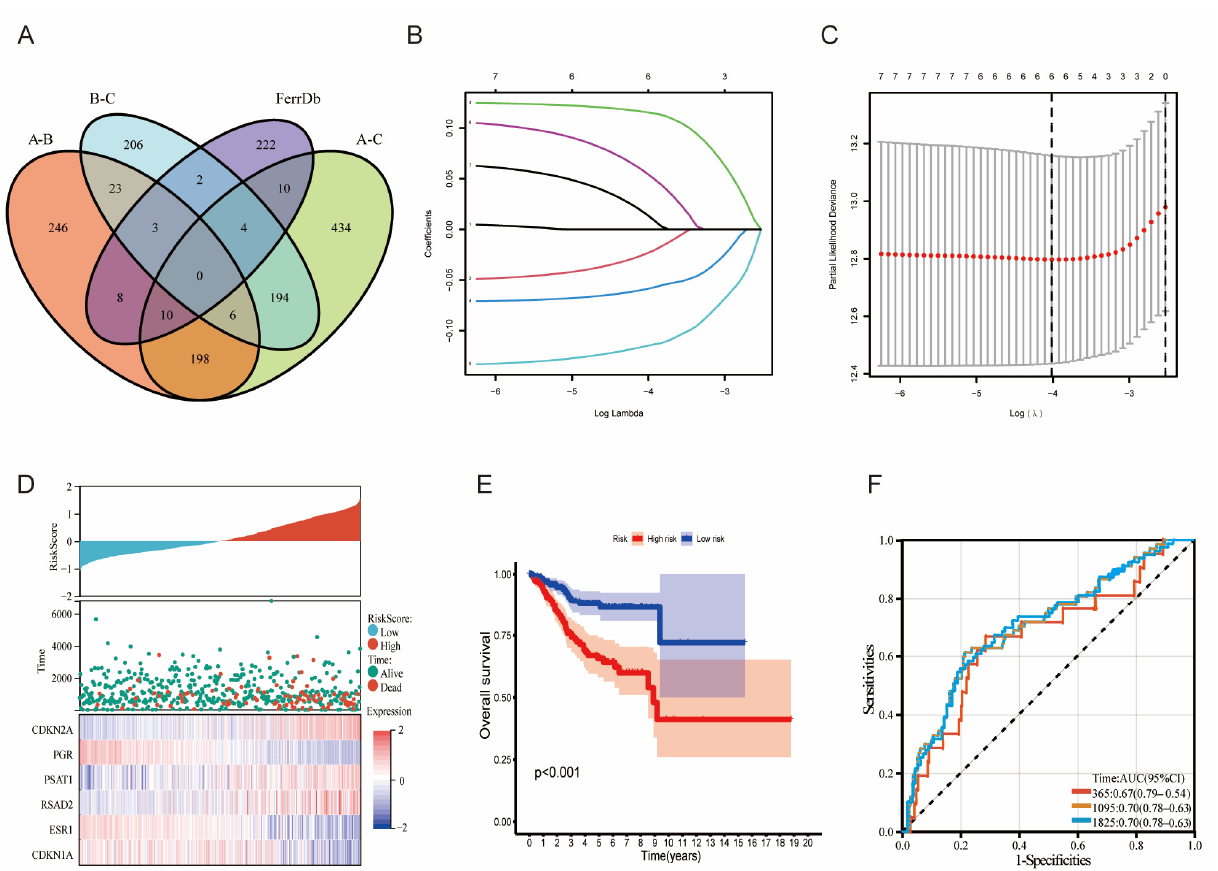
Figure 2. Constructing the LMR-FAG-related risk score. ( A ) Venn diagram showing lipid-metabolism-related and ferroptosis-associated genes (LMR-FAGs). ( B , C ) LASSO coefficient profiles and cross-validation were used to identify LMR-FAG-related genes. ( D ) Distributions of risk scores, survival status, and expression levels of six prognostic genes in UCEC. ( E ) The K-M survival analysis demonstrated that patients in the low-risk group had a better prognosis. p < 0.001. ( F ) Time-dependent ROC curve and AUC of the prognostic signature in UCEC patients from TCGA.